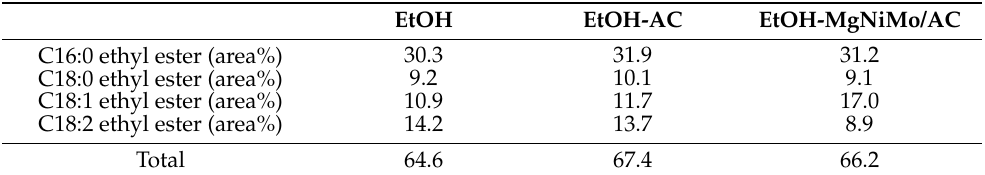
Table 4. Compositions of fatty acid ethyl esters of upgraded coffee biocrude oils by GC-MS analysis.